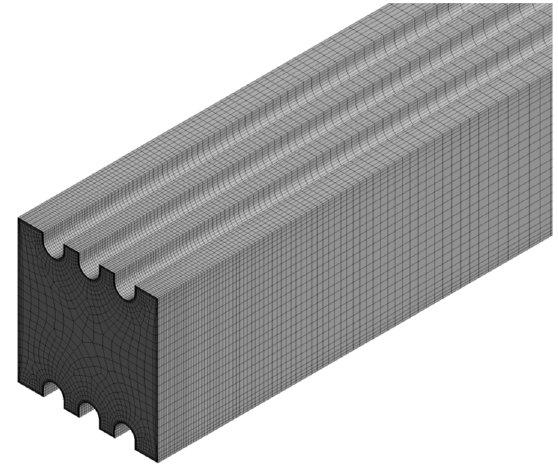
Figure 1. The configuration of the 3-D grid for a plain square minichannel.